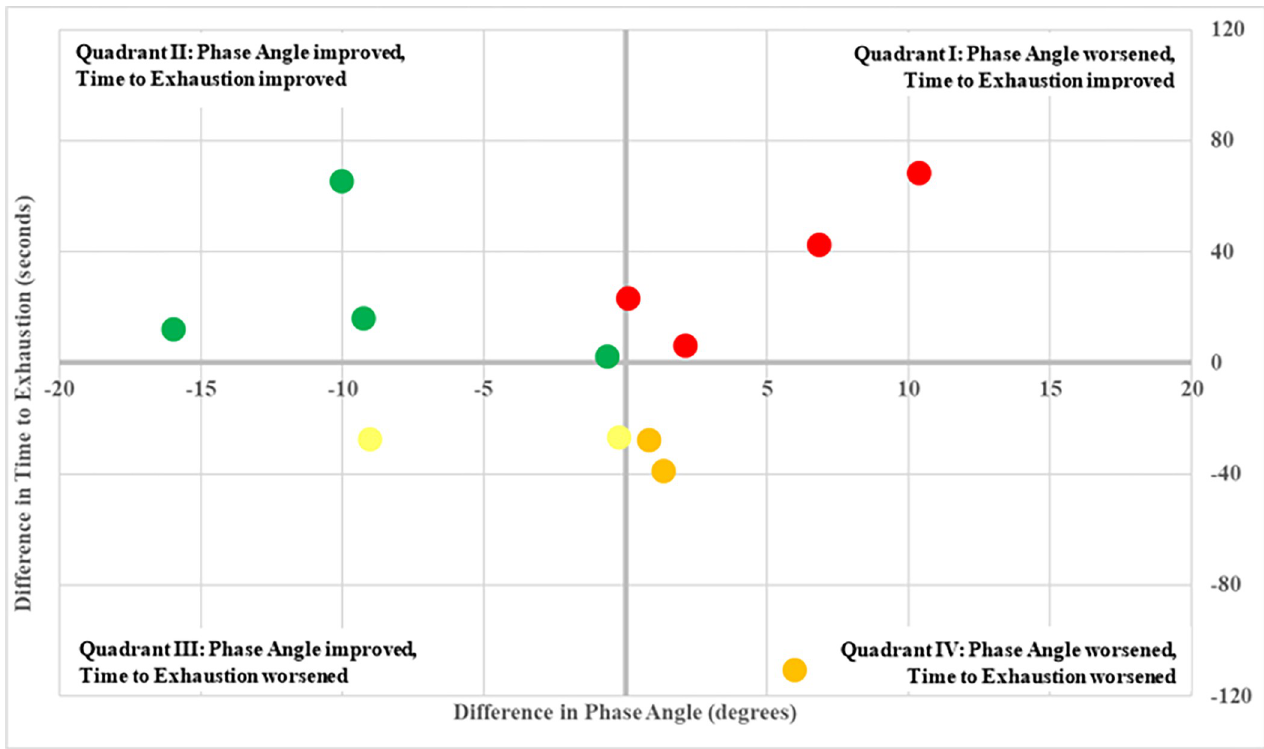
Fig 6. Differences in time to exhaustion vs. differences in phase angle. Each point was calculated by taking the values of phase angle and time to exhaustion from the visual feedback testing day and subtracting these same corresponding variable values from the testing day with no visual feedback for each participant. The colors of the points signify the quadrant that the point lies in, with red representing quadrant I, green for quadrant II, yellow for quadrant III, and orange for quadrant IV.